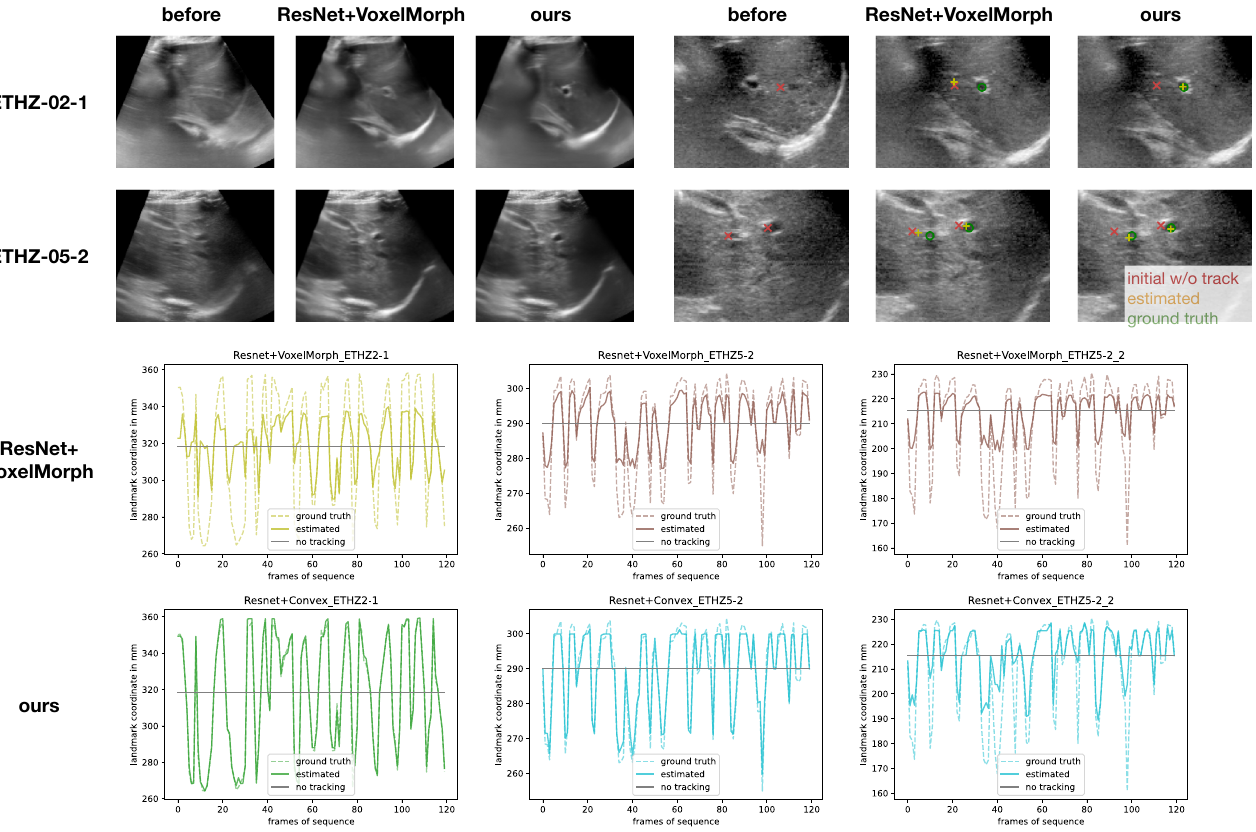
Figure 5. Comprehensive overview of selected qualitative results for the ETHZ dataset, comparing the best VoxelMorph method with our proposed method. The averaged warped images (over 120 frames) clearly demonstrate a very good motion compensation and sharp mean of our approach, whereas VoxelMorph’s result shows residual motion blur. The plots of tracking landmarks without temporal information show that VoxelMorph failed to capture larger displacement, while the convex optimisation excelled at sequences ETHZ-02-1 and ETHZ-05-2 for the first landmark and only slightly underestimated the sudden shifts in the second landmark of